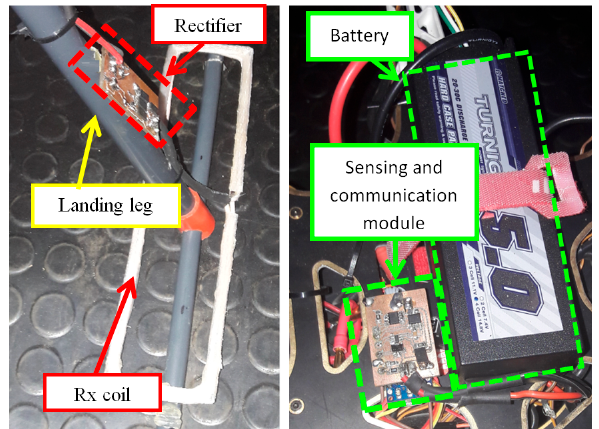
Table 2. Measured and calculated electrical quantities of the WPT system circuit when P L = 64 W.